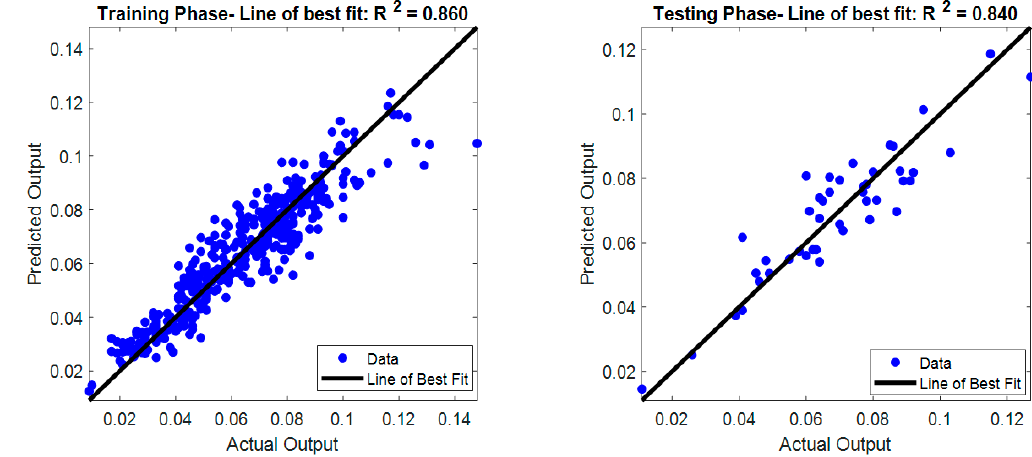
Figure 7. The optimization process of the LM-ANN approach.